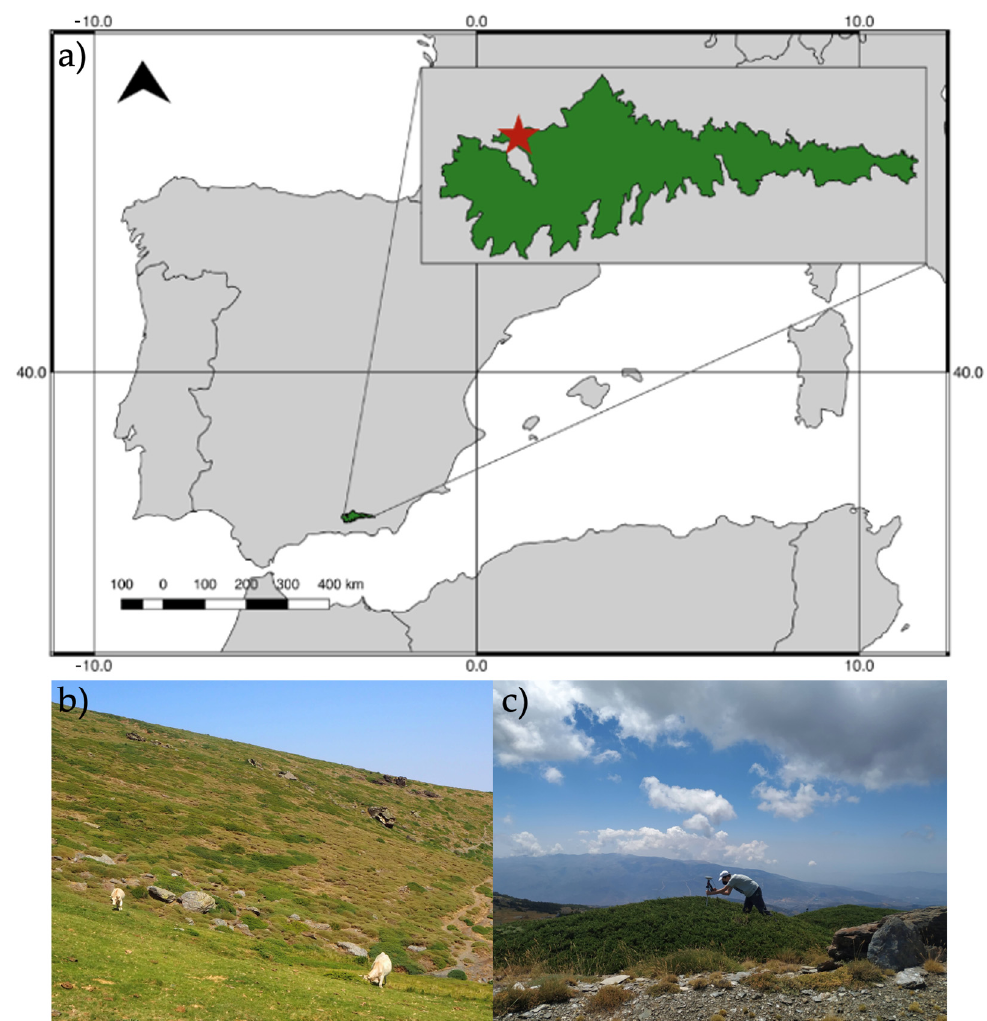
Figure 1. ( a ) Location of the study area in the Barranco de San Juan in the National Park of Sierra Nevada (Andalusia, Spain). ( b ) Traditional livestock grazing in the study area. ( c ) Ground truthing with a differential GPS of a Juniperus communis L. individual in the Sierra Nevada.